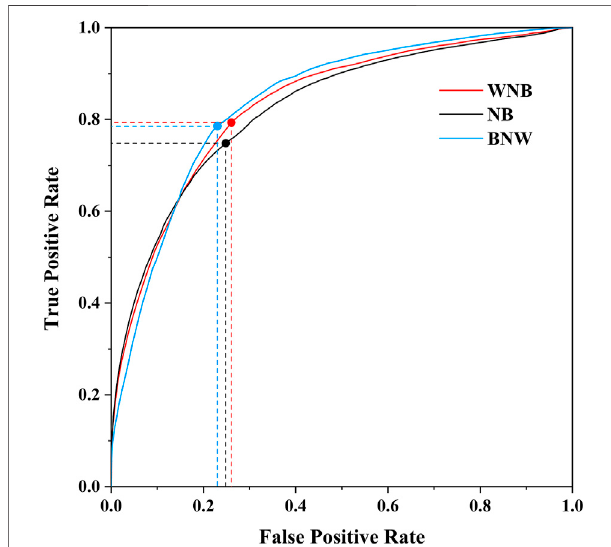
FIGURE 9 | The ROC curve of WNB, NB, and